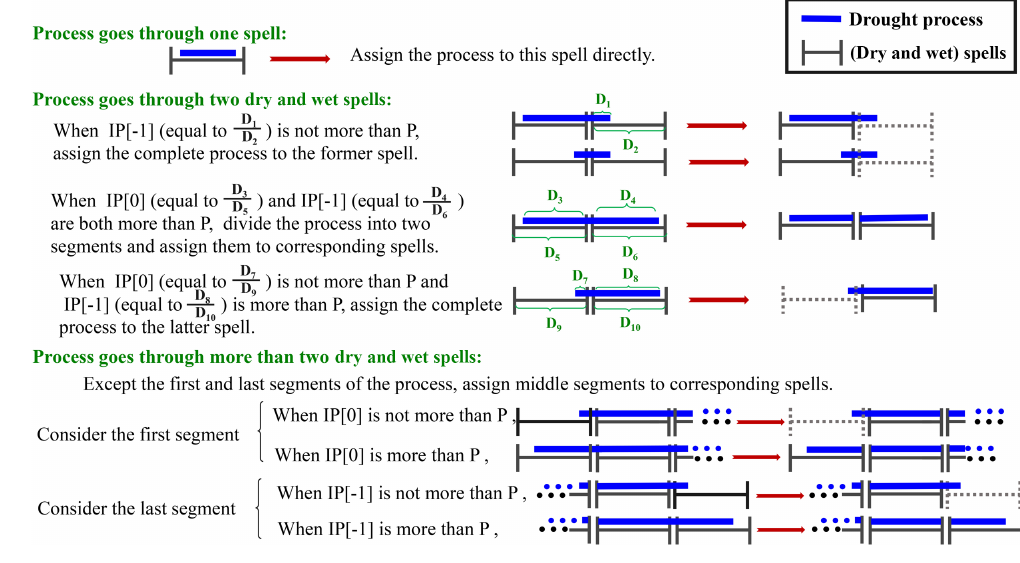
Figure 6. Process-split rules for one drought process according to dry and wet spells. IP represents intersection proportion, while P refers to critical proportion. The terms “IP[0]” and “IP[ − 1]” express the IP at the start and end segments, respectively. Table 4. Drought process segments assigned to dry and wet spells during 1979–2008 in northern China. Drought Grades Dry spell Dry–Wet spell Wet spell Wet–Dry spell Extreme